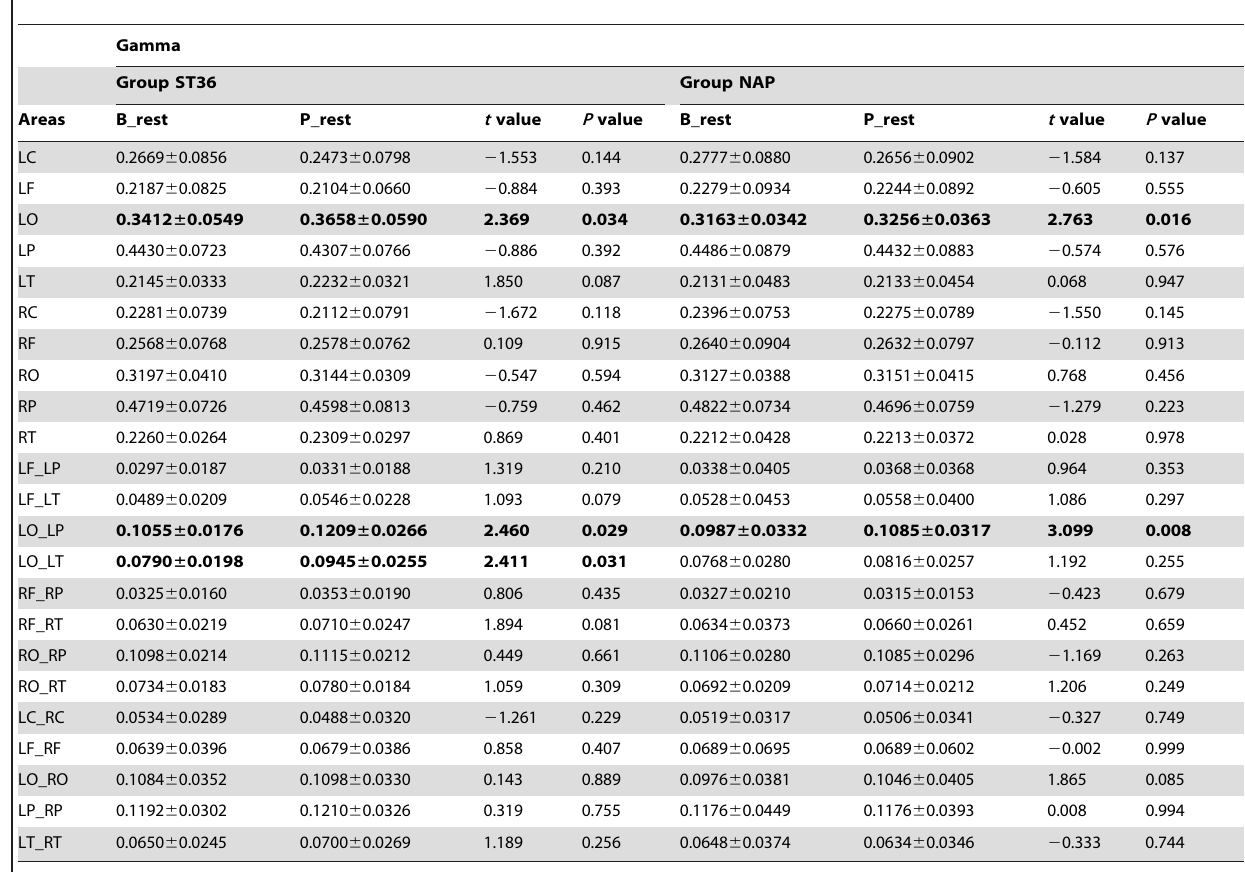
Table 3. Functional connectivity within and between main regions and statistical results in the gamma bands for the ST36 and NAP